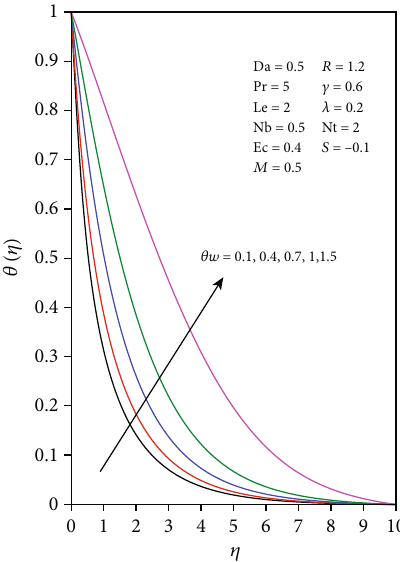
Figure 5: Temperature pro fi le for di ff erent values of θ